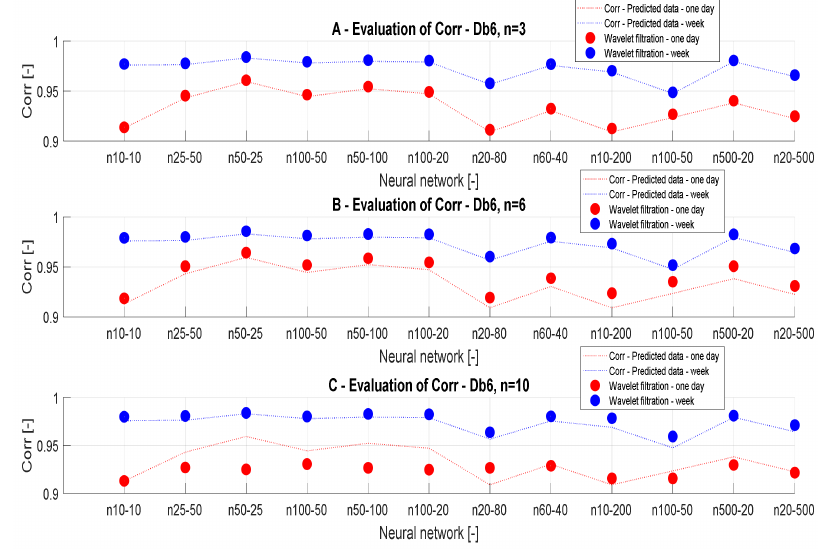
Figure 12. Correlation results, a comparison of the reference signal with wavelet-based filtration